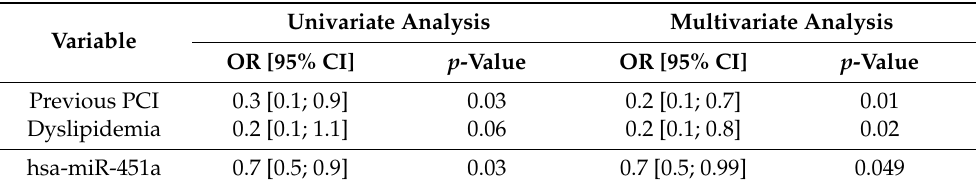
Table 3. The univariate and multivariate logistic regression analysis of clinical variables and miRNA expression profile in Group 1 compared to Group 2.